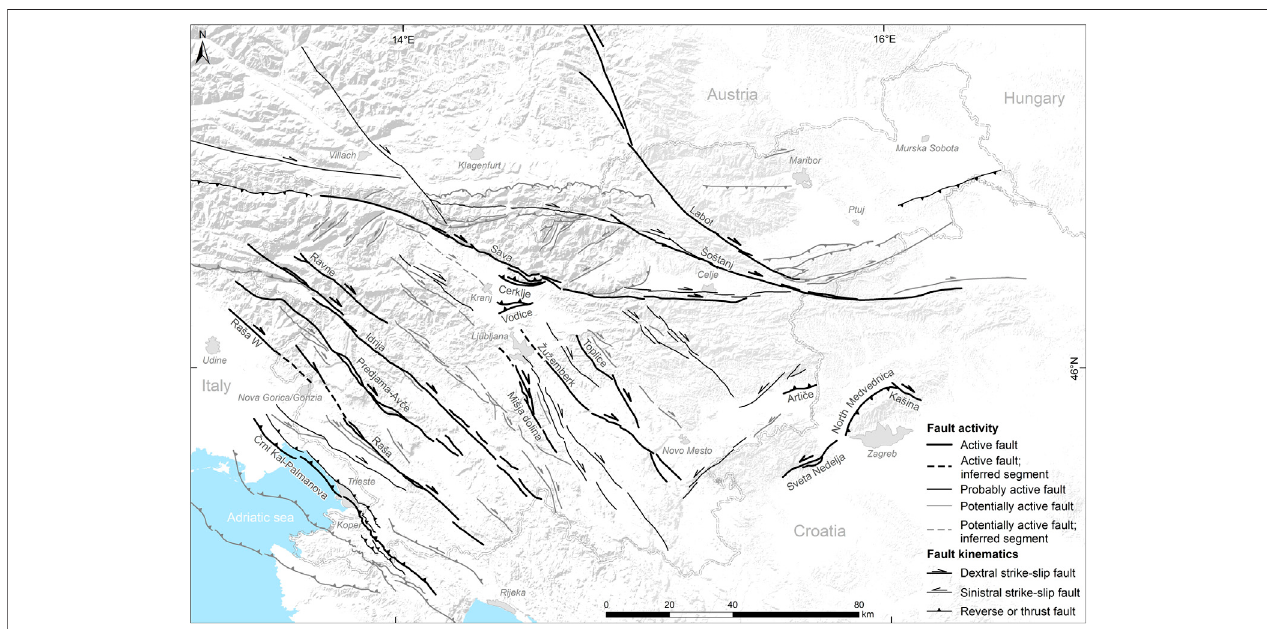
FIGURE 4 | Map of active, probably active and potentially active faults in Slovenia and the immediate vicinity.